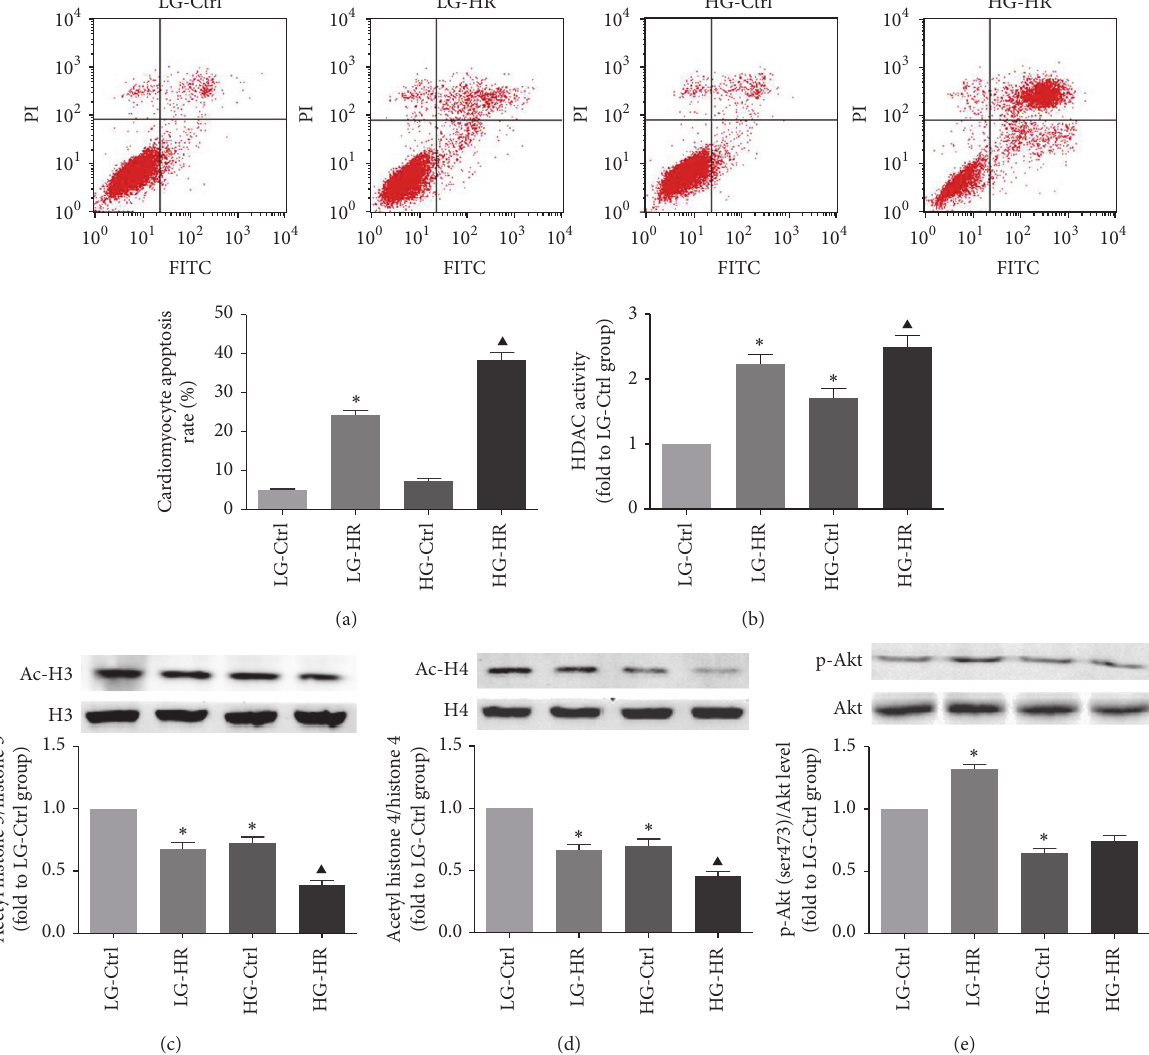
Figure 6: Apoptosis rate and HDAC activity assessment in H9C2 cells. Apoptosis of H9C2 cells was assessed by flow cytometry. (b) Total HDAC activity of cardiomyocytes in each group. (c, d) Western blot analysis of cardiomyocyte Ac-H3/H3 and Ac-H4/H4. (e) p-Akt (ser473)/Akt ratio in H9C2 cells. All values are presented as the mean ± SEM, 𝑛 = 6 /group. ∗ 𝑝 < 0.05 versus LG-Ctrl group. 󳵳 𝑝 < 0.05 versus HG-Ctrl